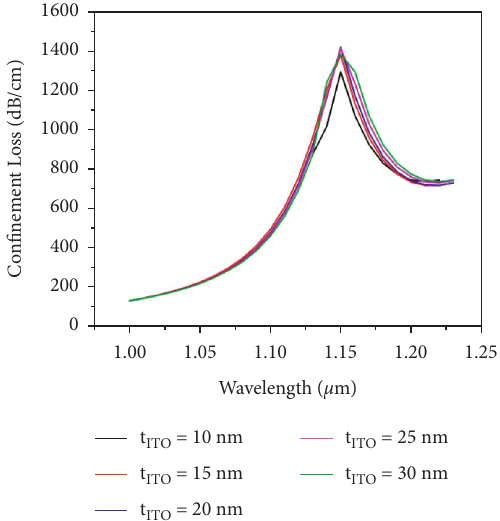
Figure 6: Differences in the loss spectra for the filter model with varied t